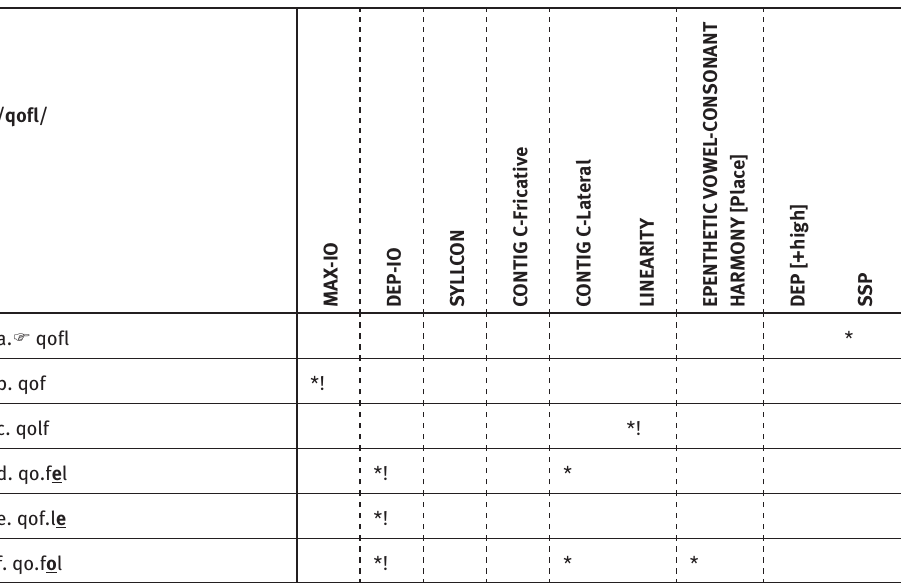
Table 18 : MAX-IO, DEP-IO, SYLLCON, CONTIG C-Fricative, CONTIG C-Lateral >>LINEARITY, EPENTHETIC VOWEL-CONSONANT HARMONY [Place], DEP